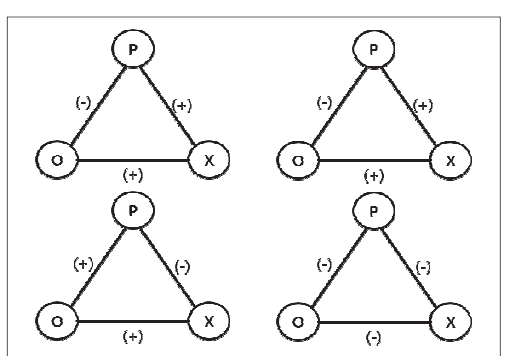
<Figure 6> Imbalanced States Among the Analyzing Person (P), Person of Comparison (O) and an Object of Comparison